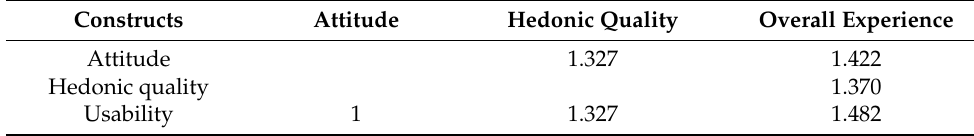
Table 4. VIF values of the structural